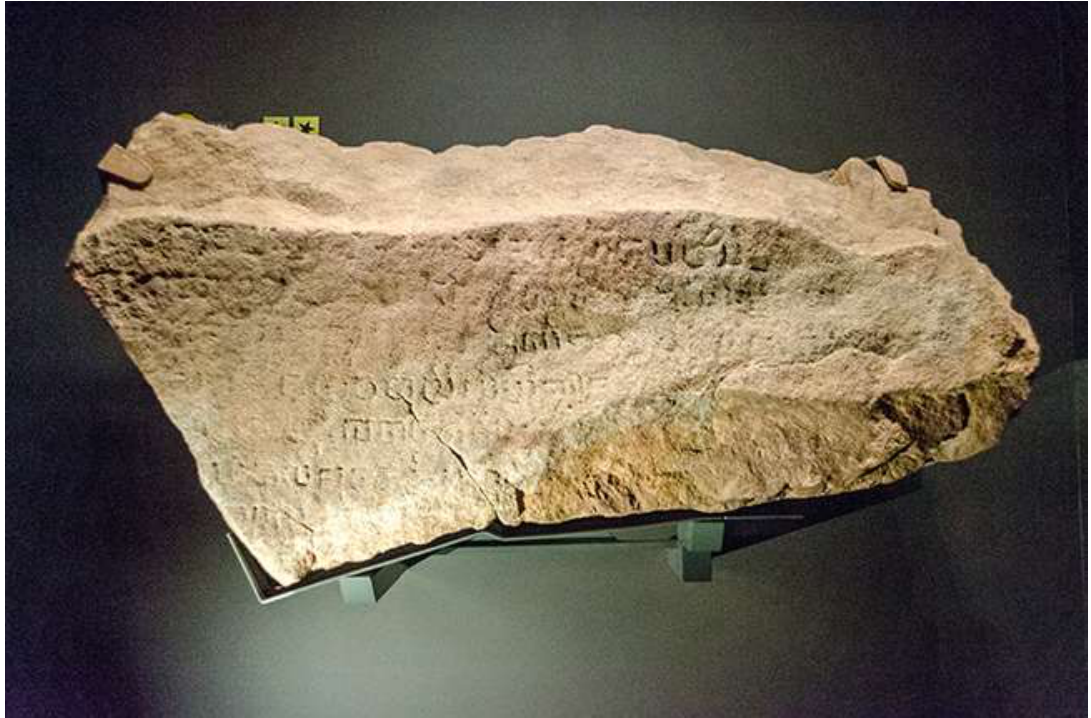
Figure 8. The Singapore Stone once stood at the mouth of the Singapore River and a fragment now sits on display at the National Museum of Singapore. Photo: Noel H.